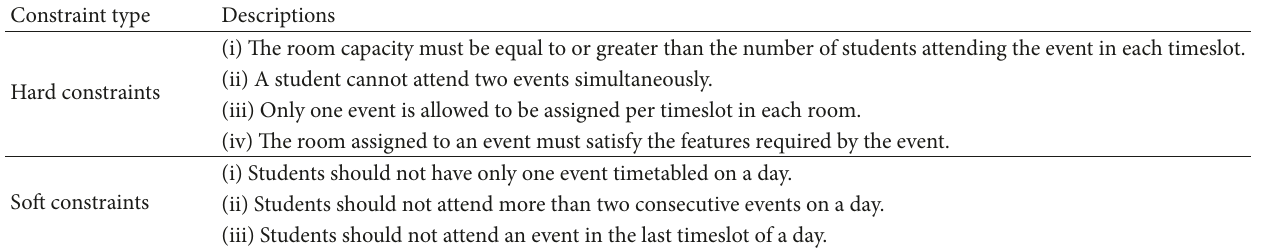
Table 4: The hard and soft constraints within the CTP adopted from Obit [51].